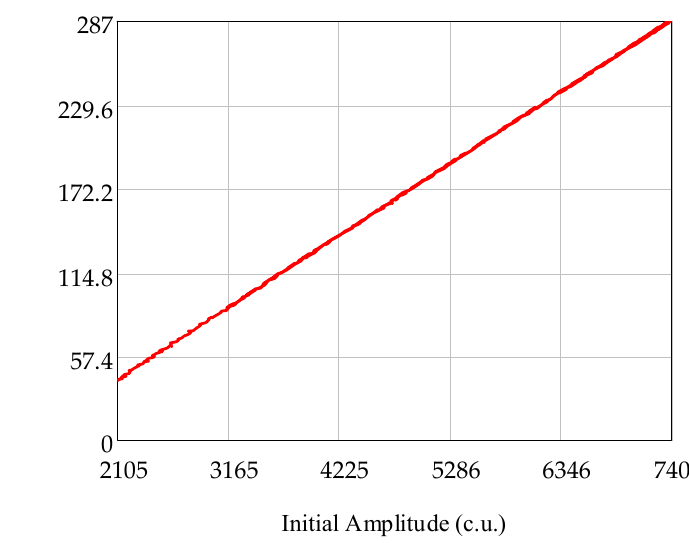
Figure 4. Dependence of the slope on the initial amplitude.